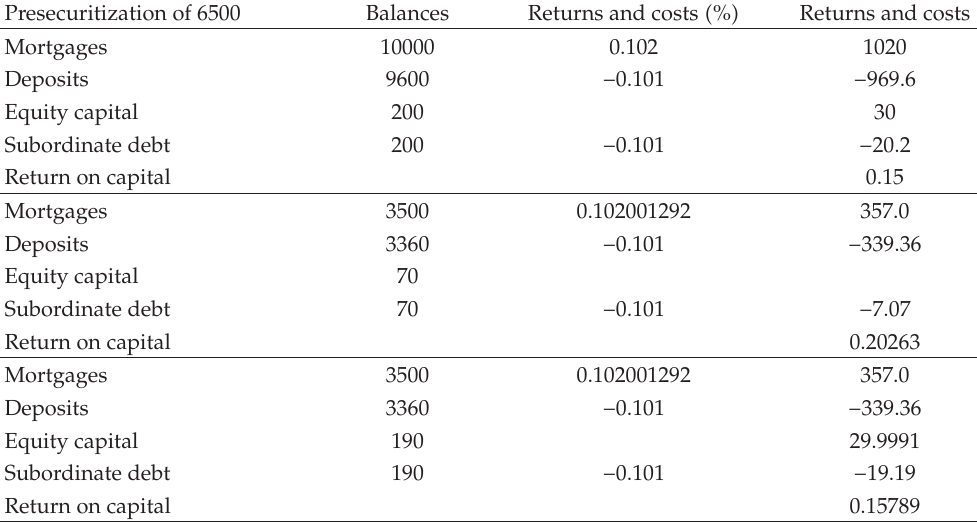
Table 7: E ff ect of securitization on return on